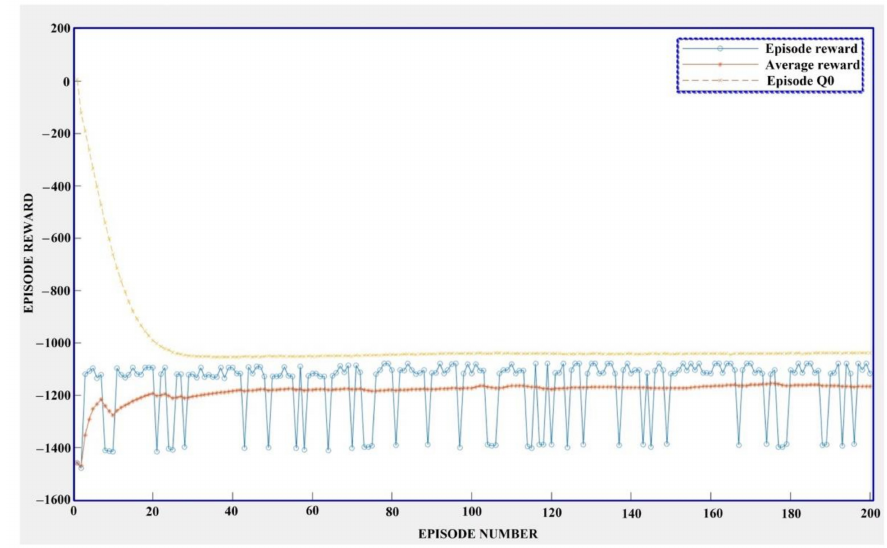
Figure 13. Training stage of the RL-TD3 agent for the correction of u dref , u qref , and i qref .